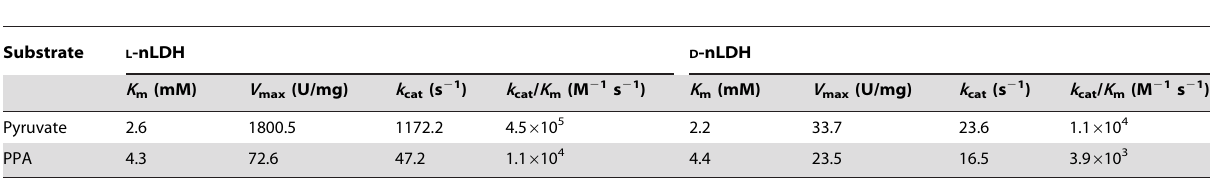
doi:10.1371/journal.pone.0019030.t002